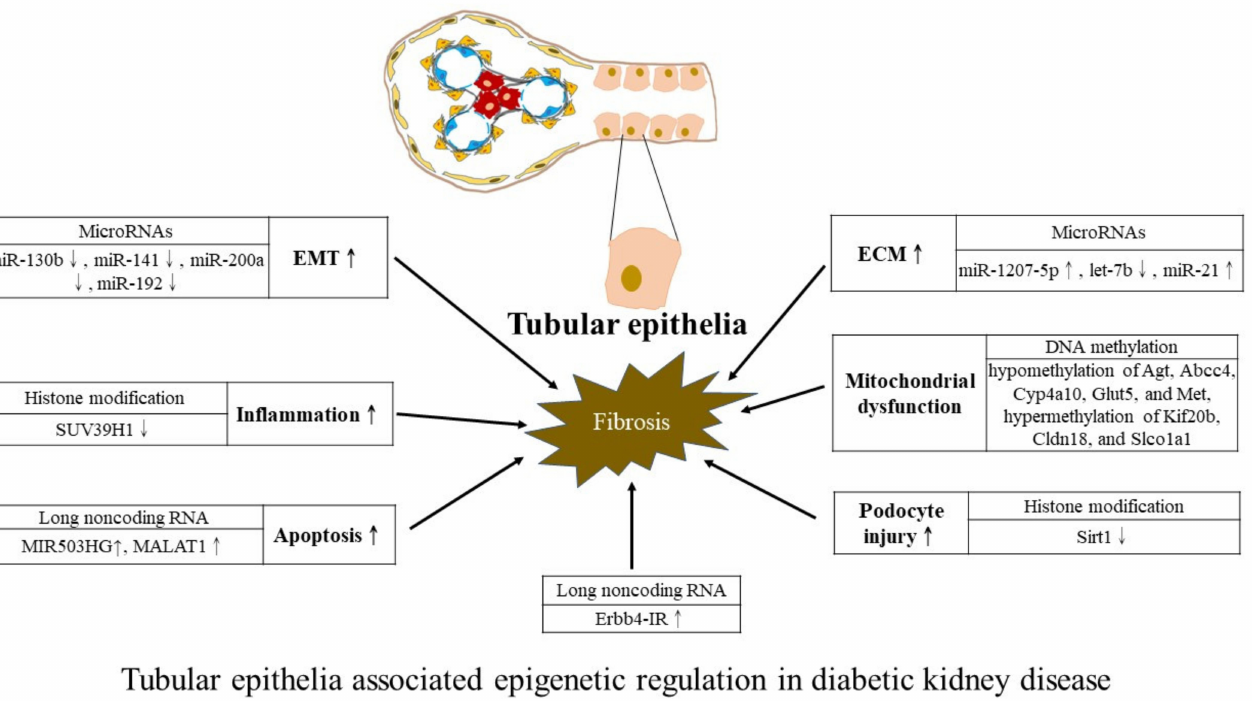
Figure 4. Tubular epithelia-associated epigenetic regulation in DKD. Denote: ECM: Extracellular matrix and EMT: Epithelial-to-mesenchymal transition. Symbols: ↑ refers to increase; ↓ refers to